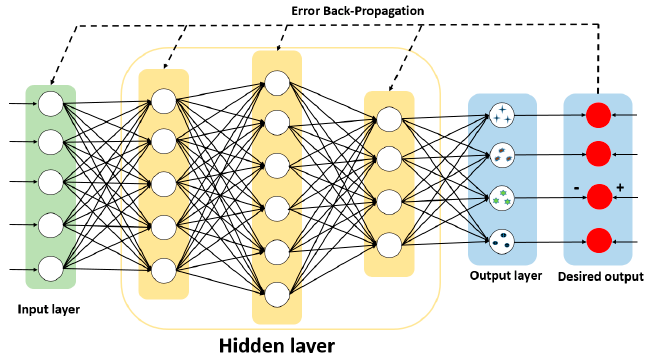
Figure 3. The schematic diagram of backpropagation algorithm structure.